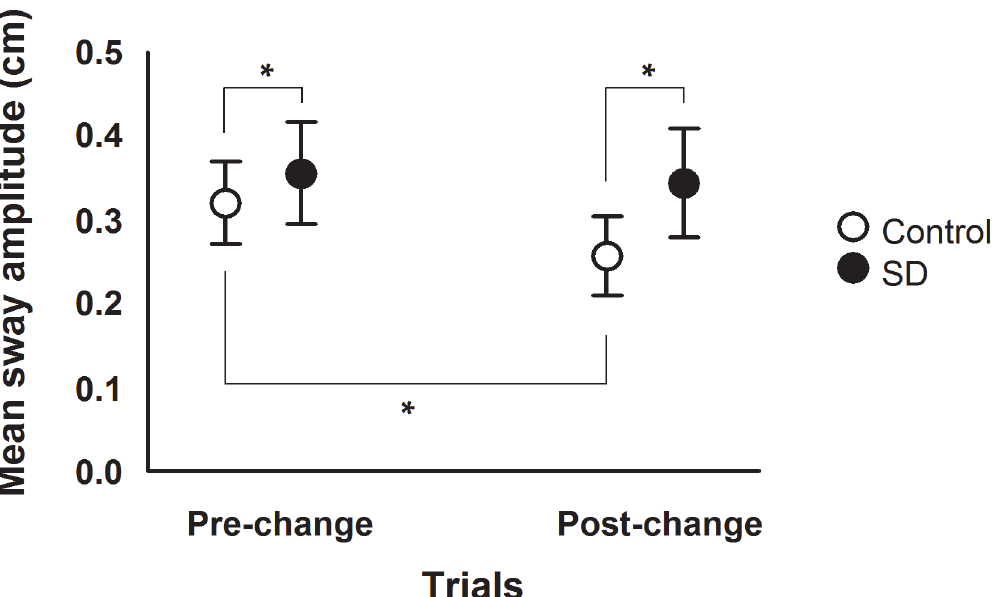
Fig 3. Mean and standard deviation values of mean sway amplitude in pre- and post-change trials for both sleep deprivation (SD) and control groups. Note: ( * ) represent significant pairwise comparisons, which was used for a group x trial interaction.